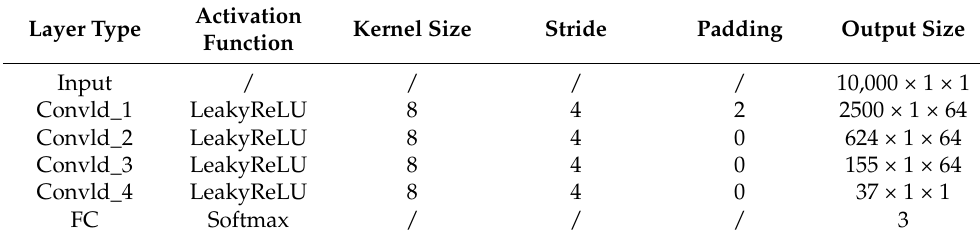
Table 2. Detailed parameters for classifier